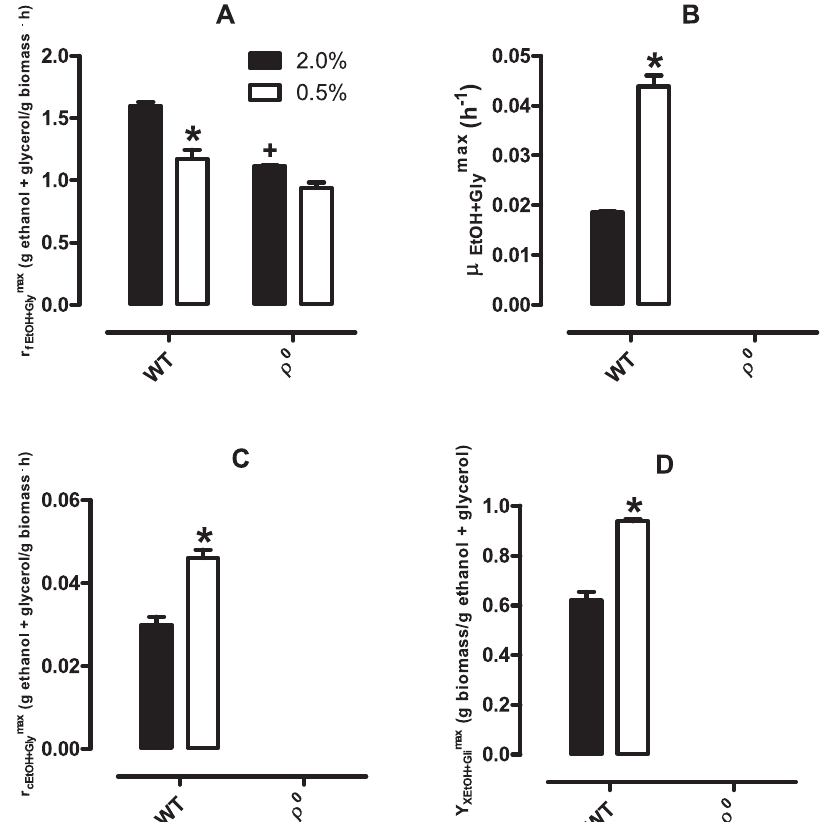
Figure 8. Maximum specific generation of ethanol/glycerol, specific growth rate in ethanol/glycerol, maximum specific consumption of ethanol/glycerol and ethanol/glycerol-to-cell conversion factors. Maximum specific generation of ethanol/glycerol (r fEtOH + Glymax , Panel A), specific growth rate in ethanol/glycerol ( m EtOH + Glymax , Panel B), maximum specific consumption of ethanol/glycerol (r cEtOH + Glymax , Panel C) and ethanol/glycerol-to-cells conversion factors (Y XEtOH + Glymax , Panel D) were calculated as described in Materials and Methods . Panel A: * p , 0.05 vs. 2.0%; + p , 0.05 vs. WT (unpaired Student’s t test).